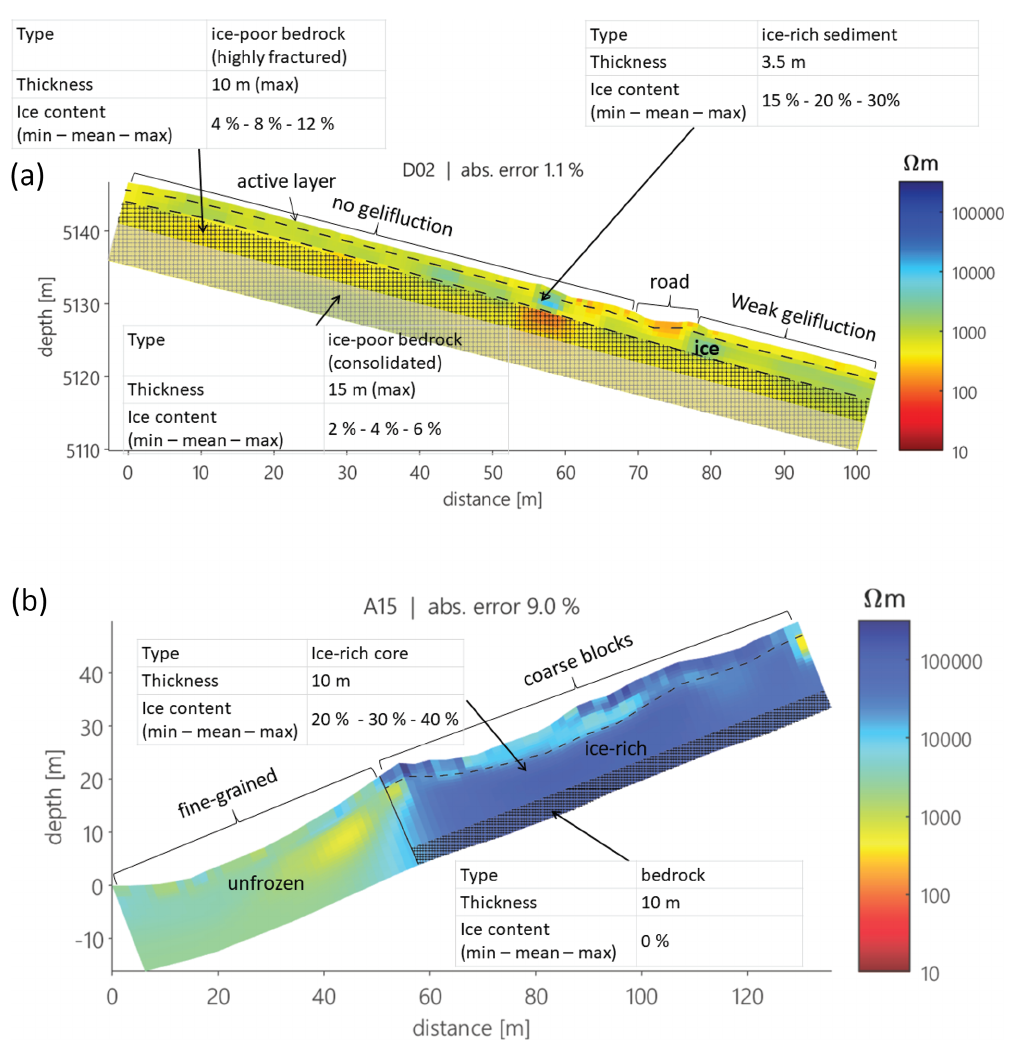
Figure 4. Examples of simplified soil stratigraphy models from both study sites ( a : Site D; b : Site A). In both cases 4PM results are not available, and ground ice contents for the different layers are estimated from the ERT tomogram and based on ground truthing from test pits and